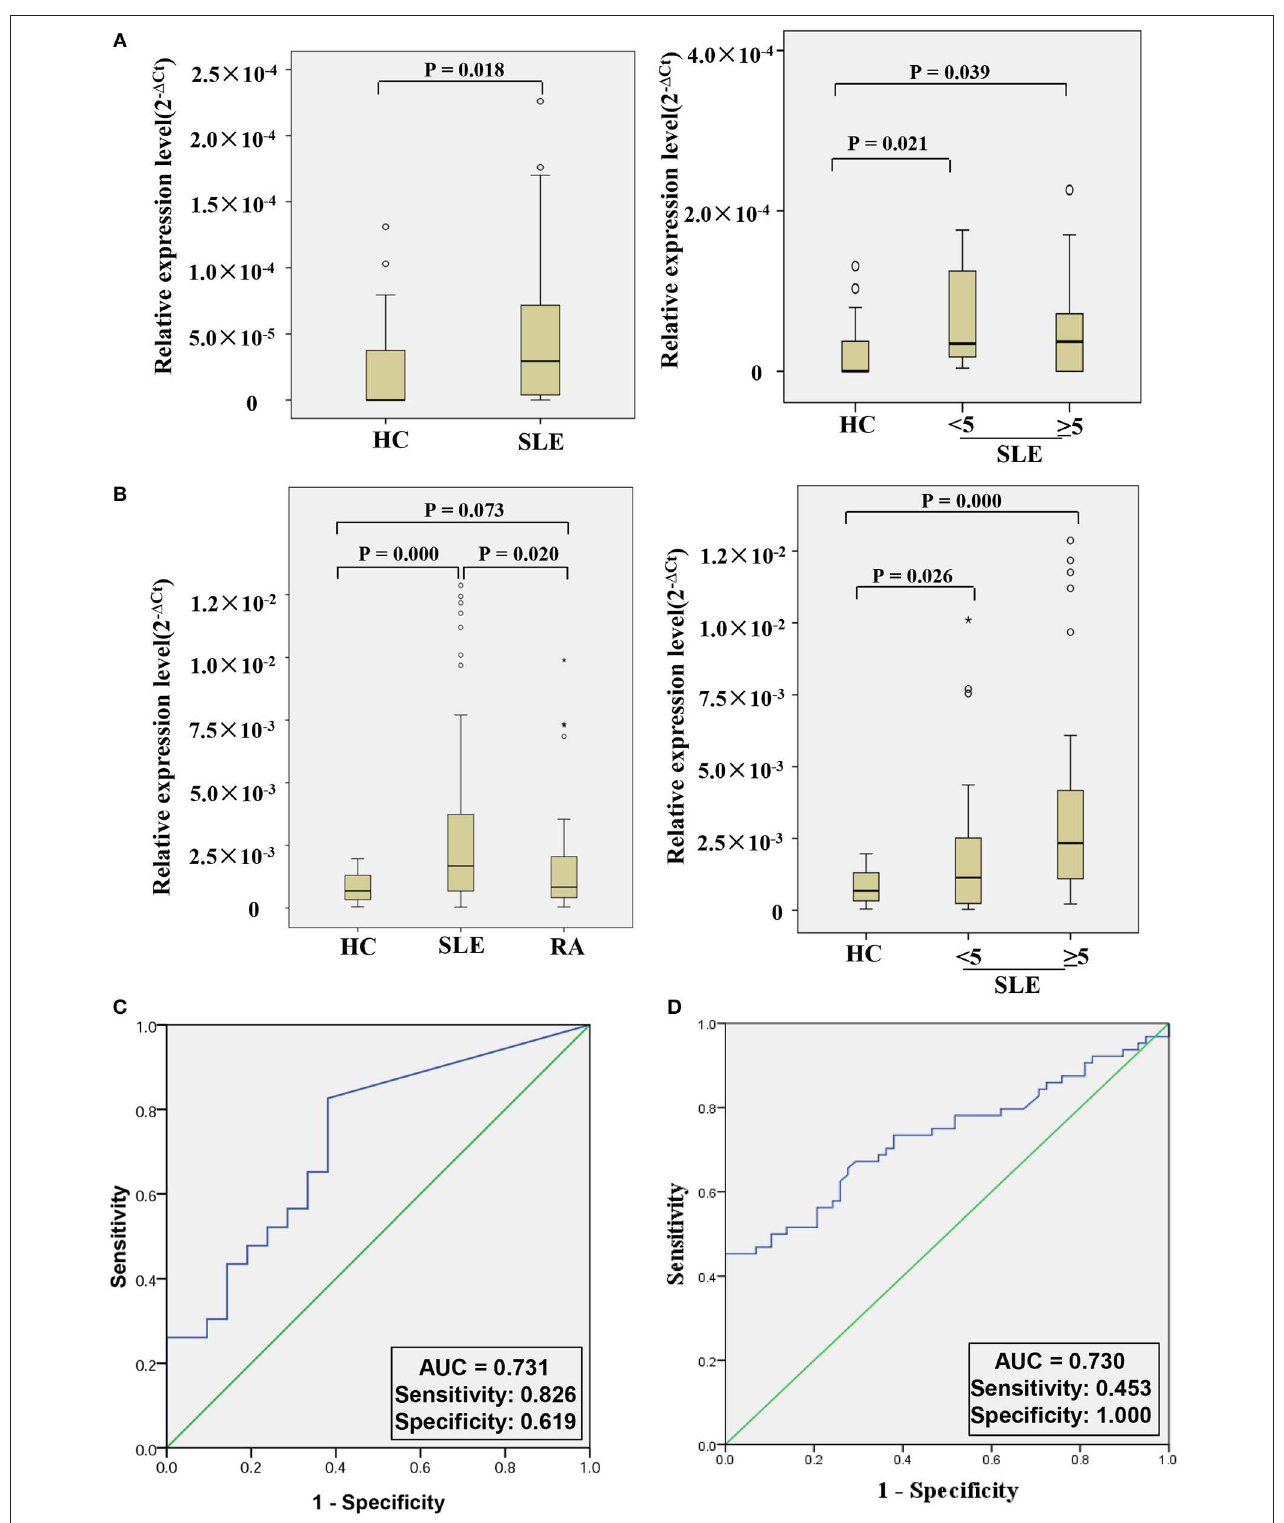
FIGURE 4 | Double validation of hsa_circ_0000479 as an SLE diagnosis marker in two additional cohorts. (A) Expression of hsa_circ_0000479 in the validation-phase cohort with 23 SLE patients (including the active group and the stable group) and 21 HCs. (B) Expression of hsa_circ_0000479 in the external validation phase cohort with 64 SLE patients (including the active group and the stable group), 58 HCs, and 50 RA patients. Data are presented as a box plot. The “ ◦ ” and “*,” respectively, indicate data that are more than 1.5-fold and 3-fold the quartile distance from the upper or lower bounds of the box. (C,D) Receiver operating characteristic (ROC) curves of hsa_circ_0000479 in the validation-phase and external validation-phase cohorts for SLE diagnosis.